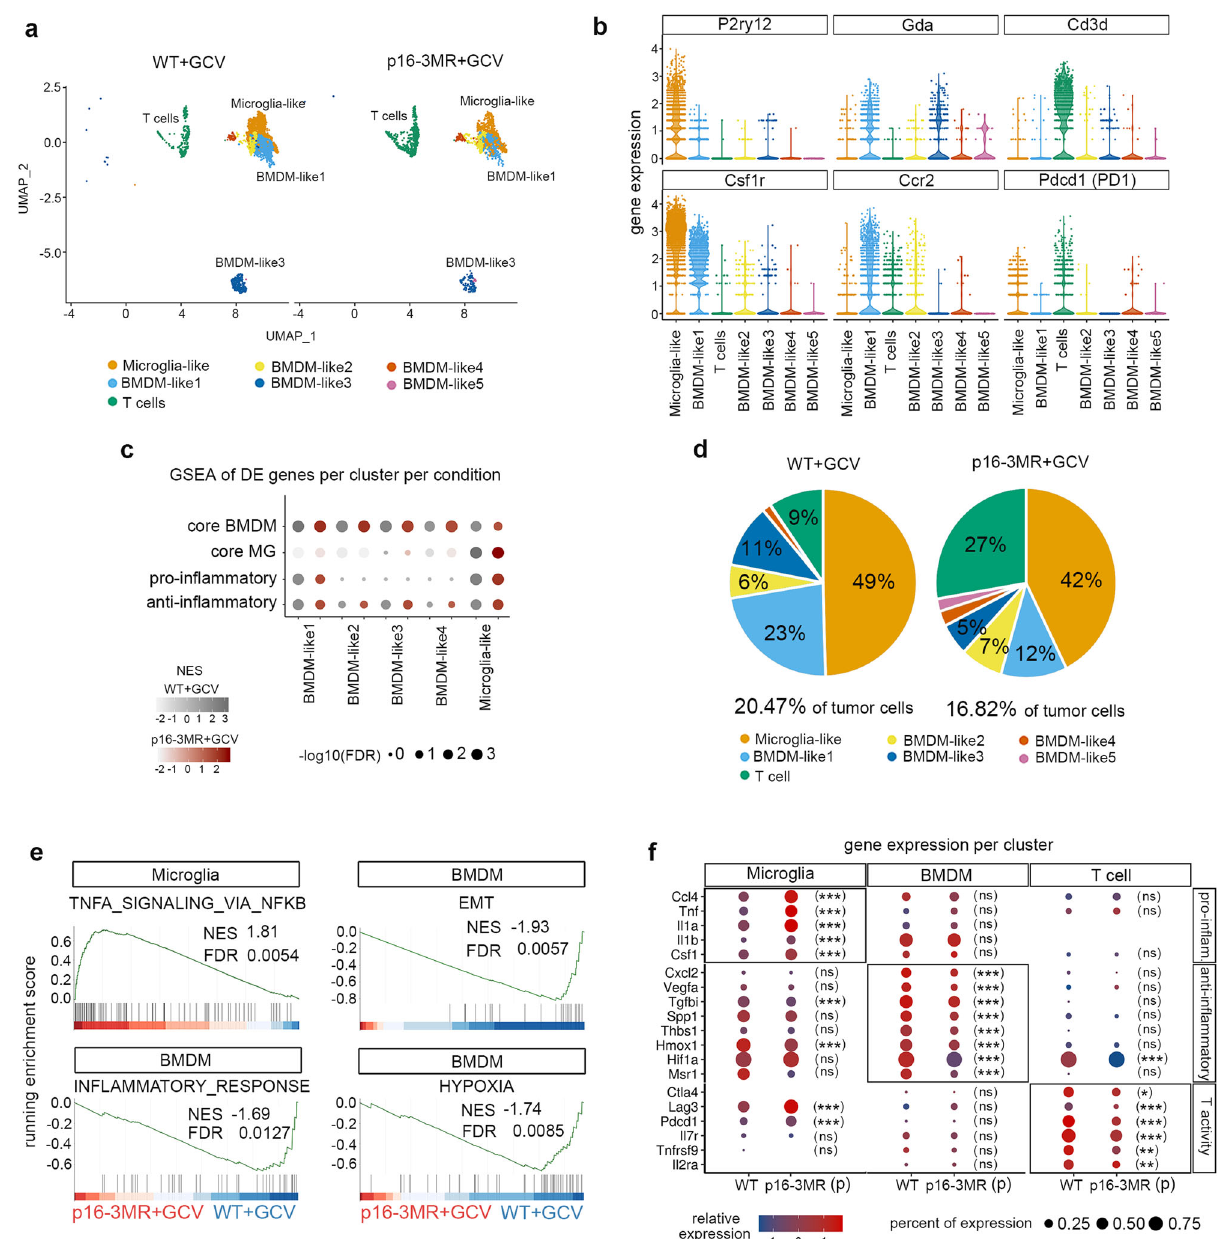
Fig. 4 | Modulation of the immune compartment following p16 Ink4aHi cells partialremoval.a UMAPplotsof CD45 +cellsinWT+GCVandp16-3MR+GCVGBMs at a 0.5 resolution and annotated cell type. b Violin plots representing the expression of selected DE genes (FDR<0.05; avlogFC>0.25) per cluster in WT +GCV GBMs. c GSEA dot plot of DE genes (FDR<0.05; avlogFC>0.25) in WT+GCV (gray dots) and p16-3MR+GCV (red dots) CD45 +clusters of core-BMDM, core-MG, pro-in fl ammatory and anti-in fl ammatory pathways as de fi ned in Bowman et al. 45 and Darmanis et al. 32 (Supplementary Data 1). d Chart pies representing the per- centage of CD45 +cells per cluster in WT+GCV and p16-3MR+GCV GBMs. e GSEA graphs representing the enrichment score of Hallmark gene lists in p16-3MR+GCV compared with WT+GCV microglia clusters and pooled BMDM clusters. The